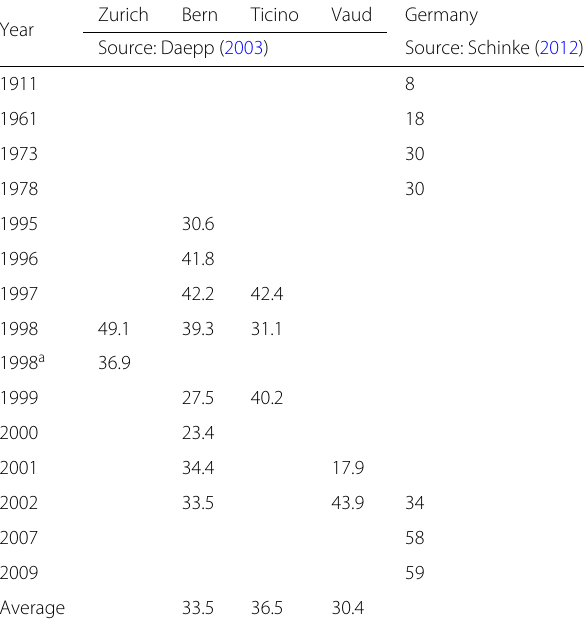
Table 2 The importance of inter vivos gifts inter vivos gifts in percent of the volume of